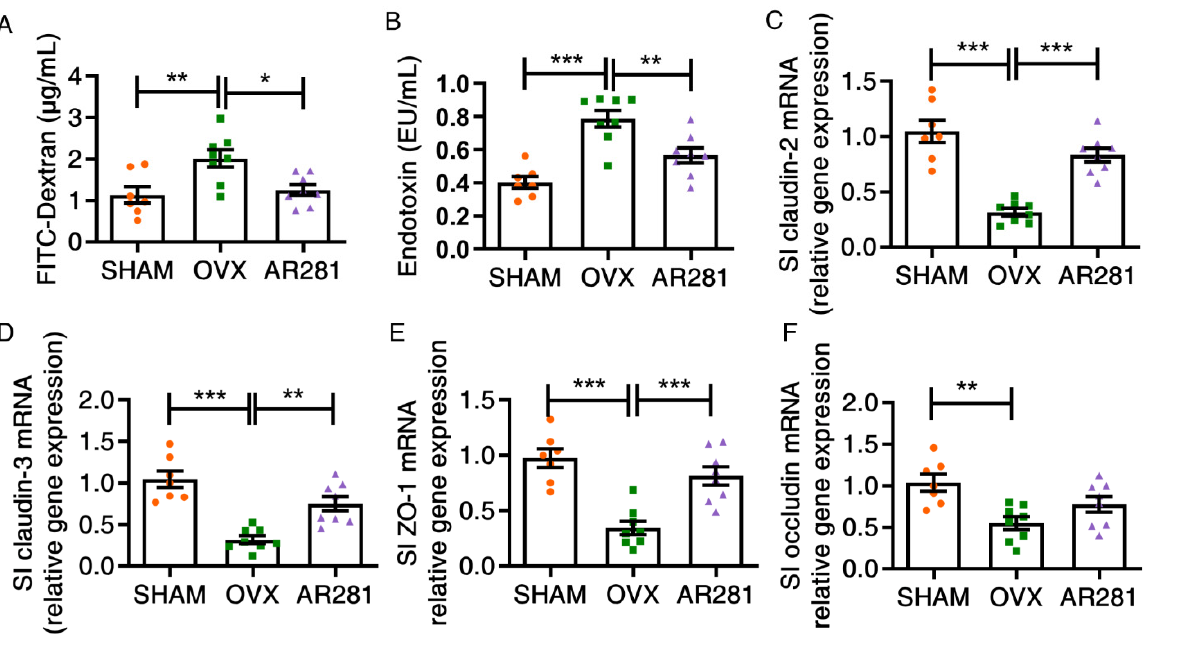
Figure 2. The effects of L. brevis AR281 on the integrity of gut epithelial barrier: ( A ) the levels of FITC-dextran in serum; ( B ) the contents of Endotoxin in serum; ( C – F ) the expression of claudin-2 and claudin-3, ZO-1, and occludin. Data are shown as mean ± SEM ( n = 8 per group, except n = 7 in the SHAM group) and are normally distributed. * p < 0.05, ** p < 0.01, and *** p < 0.001.